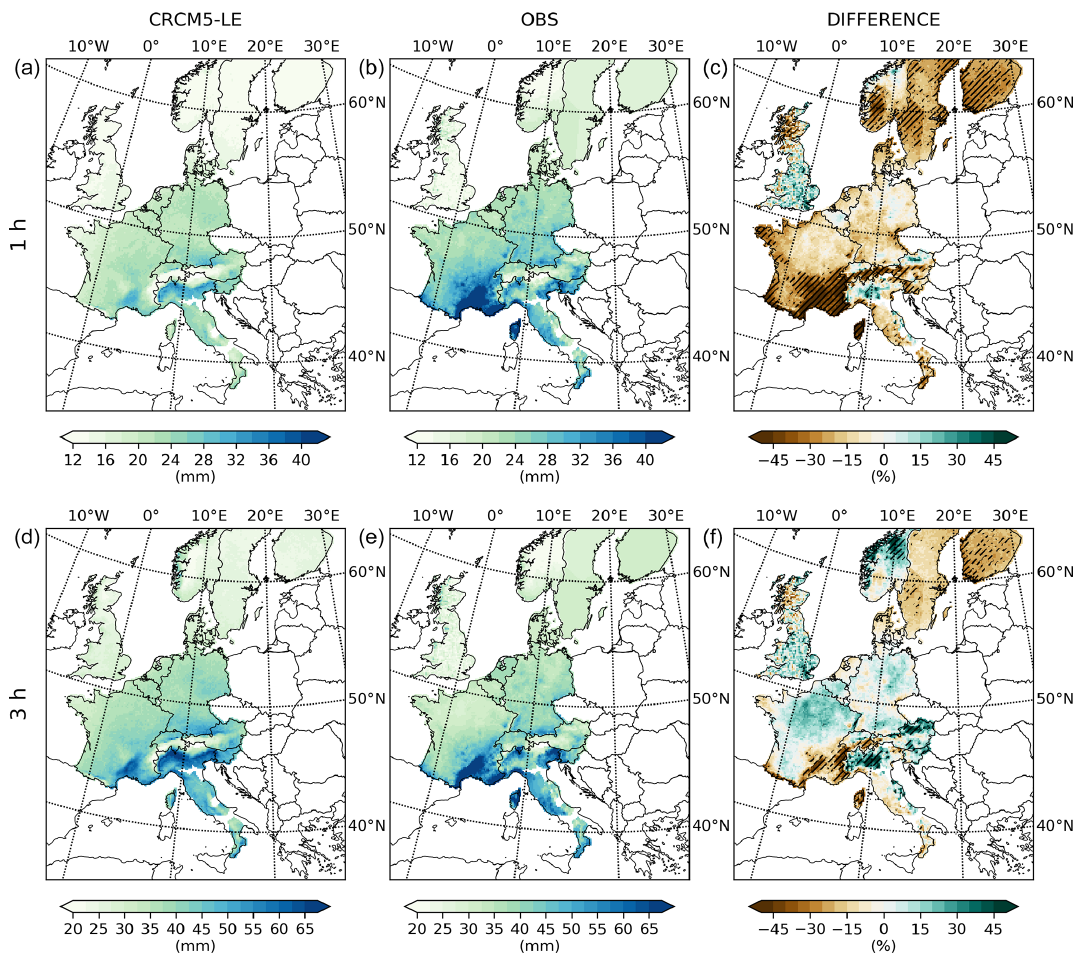
Figure 2. The 10-year return levels of hourly (a–c) and 3h (d–f) precipitation over parts of Europe. The CRCM5-LE data (a, d) are compared to an observational data set (b, e) , and the percentage deviation (c, f) is shown. Areas where the observations are not in the range of the CRCM5-LE are